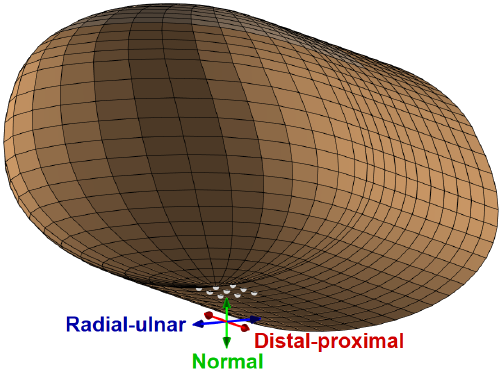
Figure 5. The nine nodal locations (grey dots) across which harmonic forces are applied, along with the three tested force